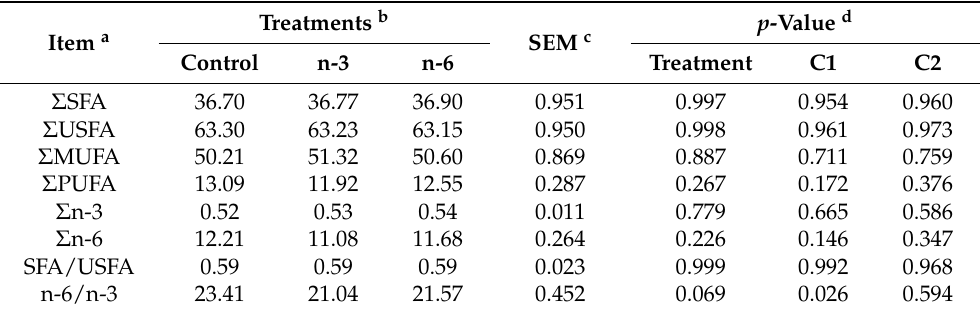
Table 10. Effect of supplementation of milk enriched with n-3 and n-6 on the quality of the lipid fraction of sows’